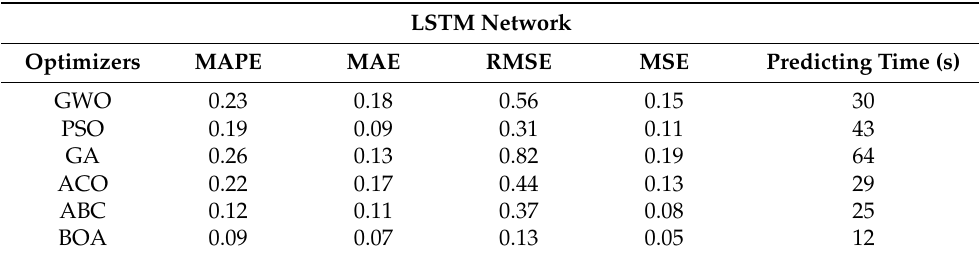
Table 4. Performance of the dissimilar hyperparameter optimizers in the LSTM network on the AEP